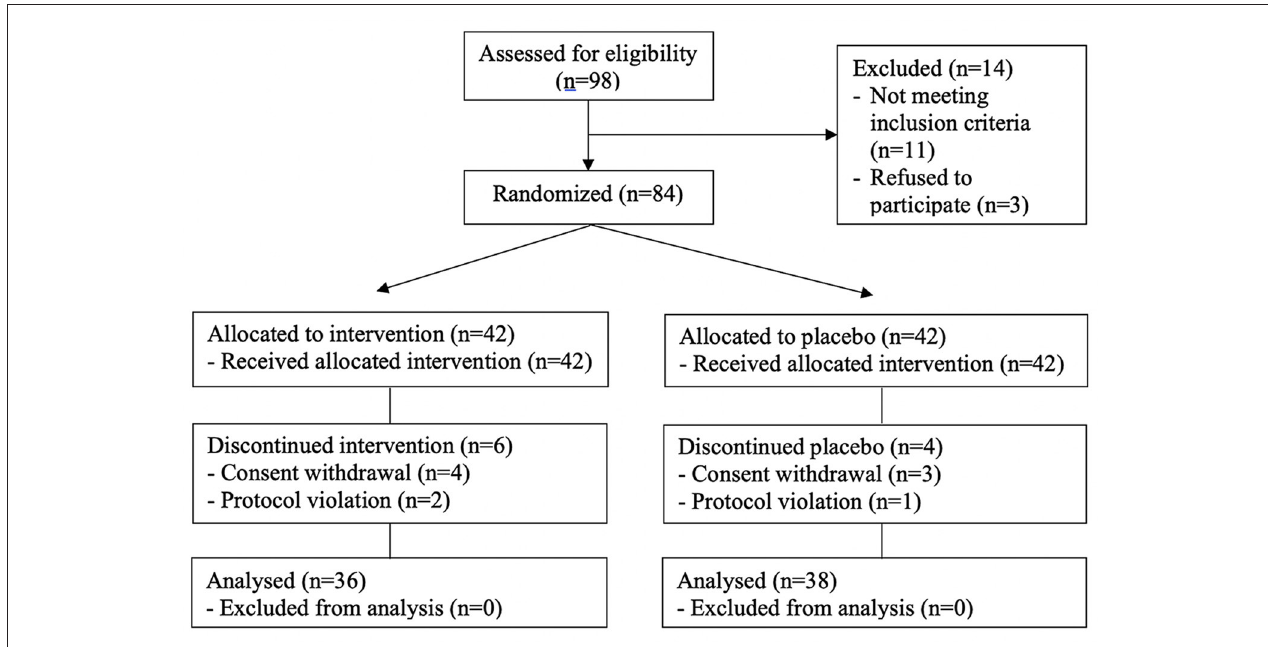
FIGURE 1 | CONSORT flow